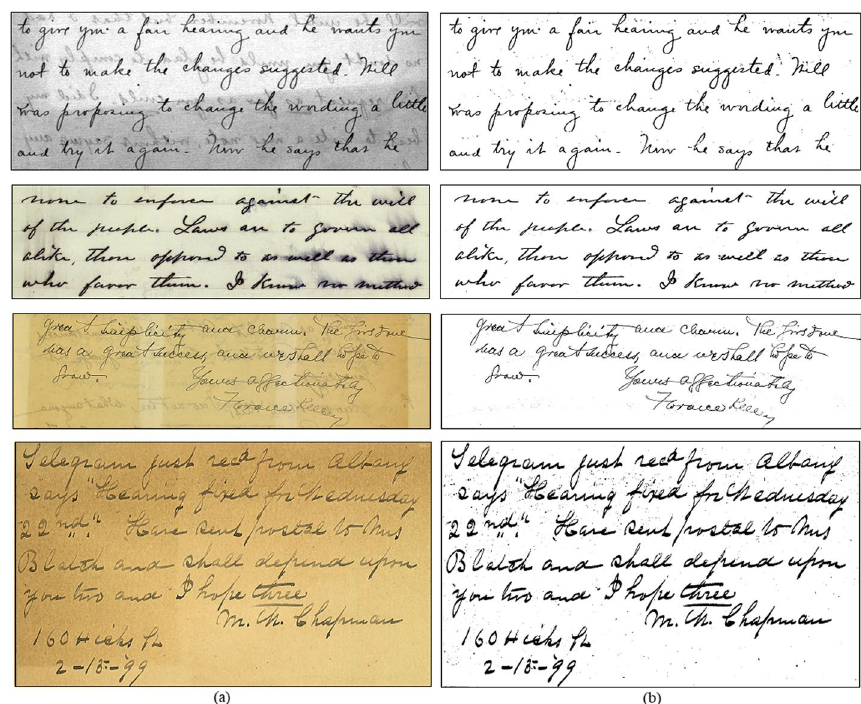
Fig. 4 Images binarization results from DIBCO 2012: a Original degraded images, b recovered text by the proposed non-local